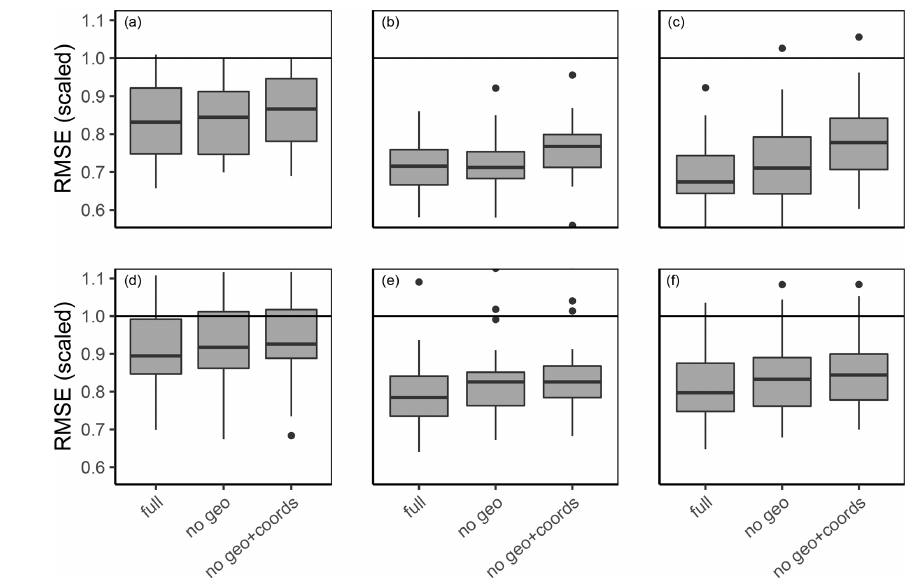
Figure 8. Model performance as RMSE for three particle size contents for (a, d) clay, (b, e) silt, and (c, f) sand. The models (a) , (b) , and (c) are for 10cm depth, while (d) , (e) , and (f) are for 70cm depth. Models were built using either all predictors (full), leaving out the geologic predictors (no geo) or leaving out geology, latitude, and longitude (no geo + coords). The black horizontal lines stand for an RMSE of one, which equals the RMSE of predicting the observed mean.